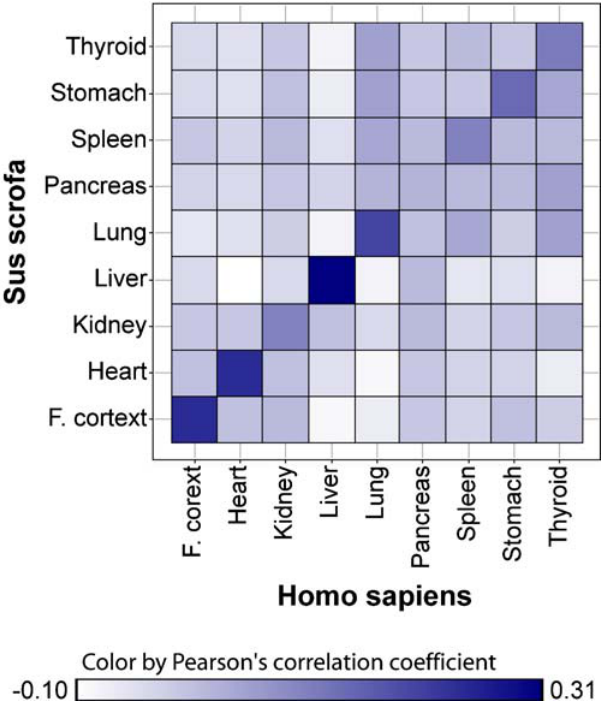
Figure 5. Correlation in gene expression between common tissues of pig and human. Pearson’s correlation coefficients computed for pairs of common tissues from pig and human. Color scale from white to dark blue represents correlation coefficients from 2 0.10 to 0.31.